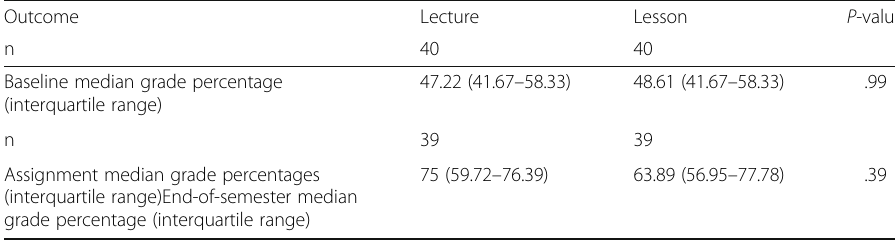
Table 1 Student performance on baseline, post-class, and retention assessments Outcome Lecture Lesson P -value n